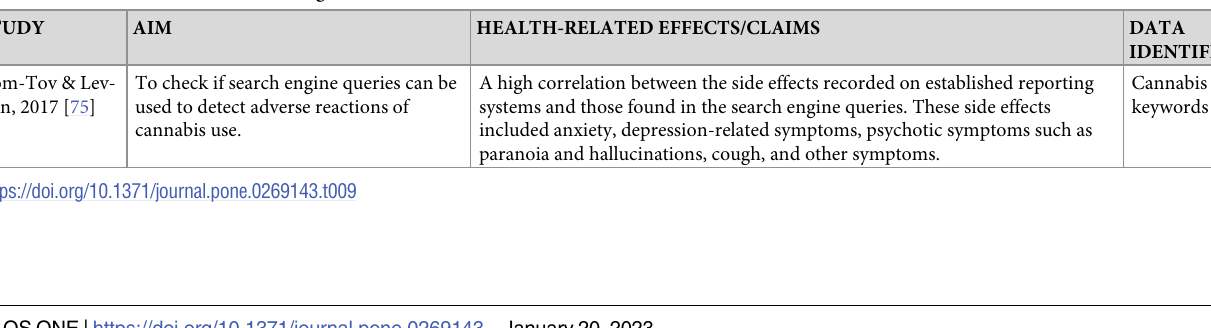
Table 9. Cannabis related to adverse drug reactions and adverse